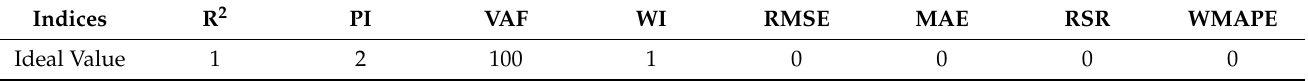
Table 2. Ideal values of different performance parameters.